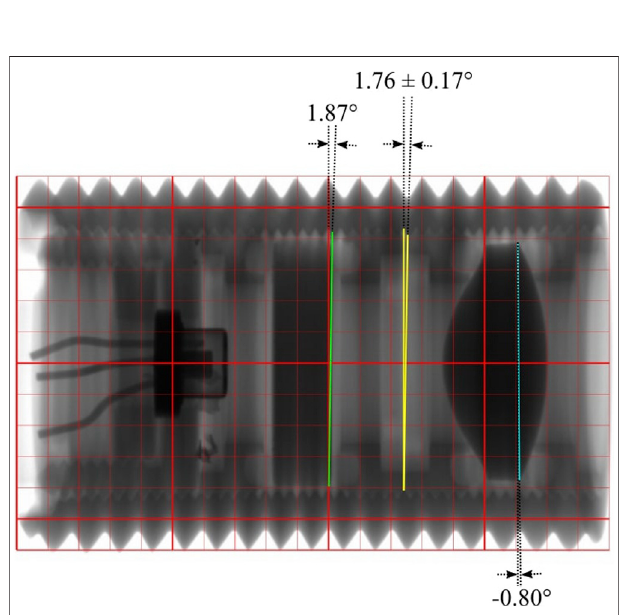
FIGURE9| Lenstube optical component positional alignmenttest. Helix anglewasmeasured to be1.76 ± 0.17 ° . The inclination oftheoptical fi lterwas 1.87 ° , and the condenser lens was − 0.80 °